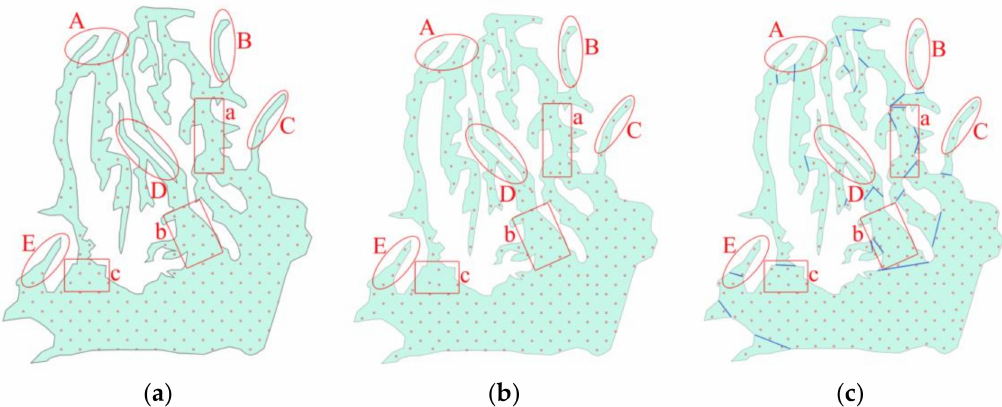
Figure 9. Complex area 1 (the blue solid line is the segmentation line). ( a ) Filling using the traditional three-square type method. ( b ) The effect of the filling method based on simple segmentation. ( c ) The effect of the method proposed in this paper.